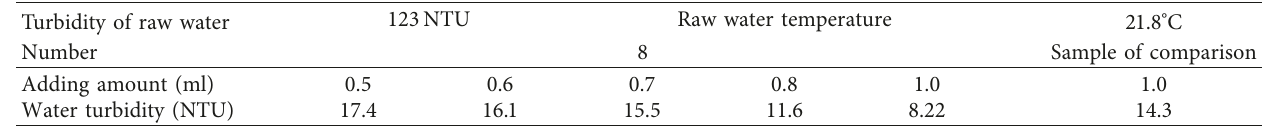
Table 10: Formula no. 8 treatment of tap water source water-related case.